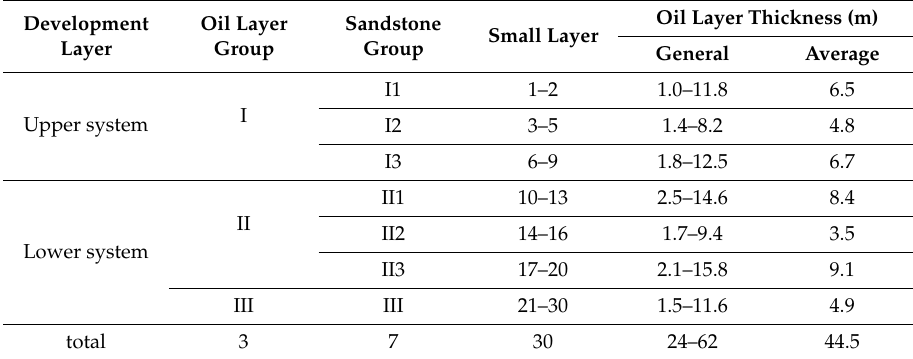
Table 1. Oil layer group division and oil layer thickness statistics of the Du 66